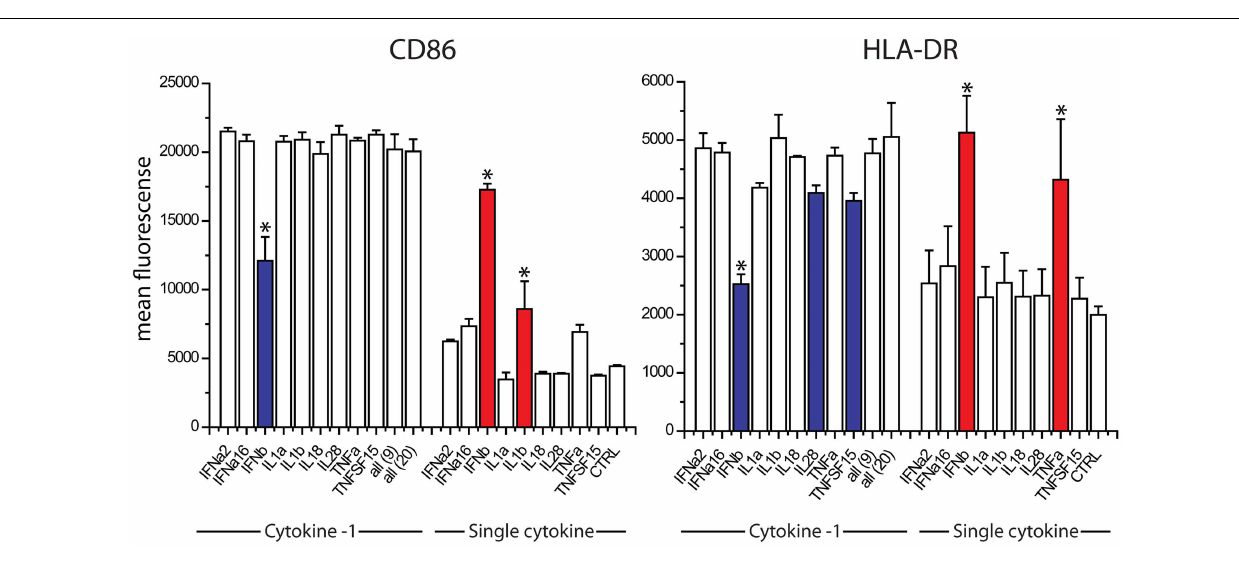
FIGURE 5 | Contribution of individual cytokines in nine cytokine paracrine signal . Maturation marker expression of DCs after 8h to exposure to all nine cytokines, all leave-one-out combination of eight cytokines and